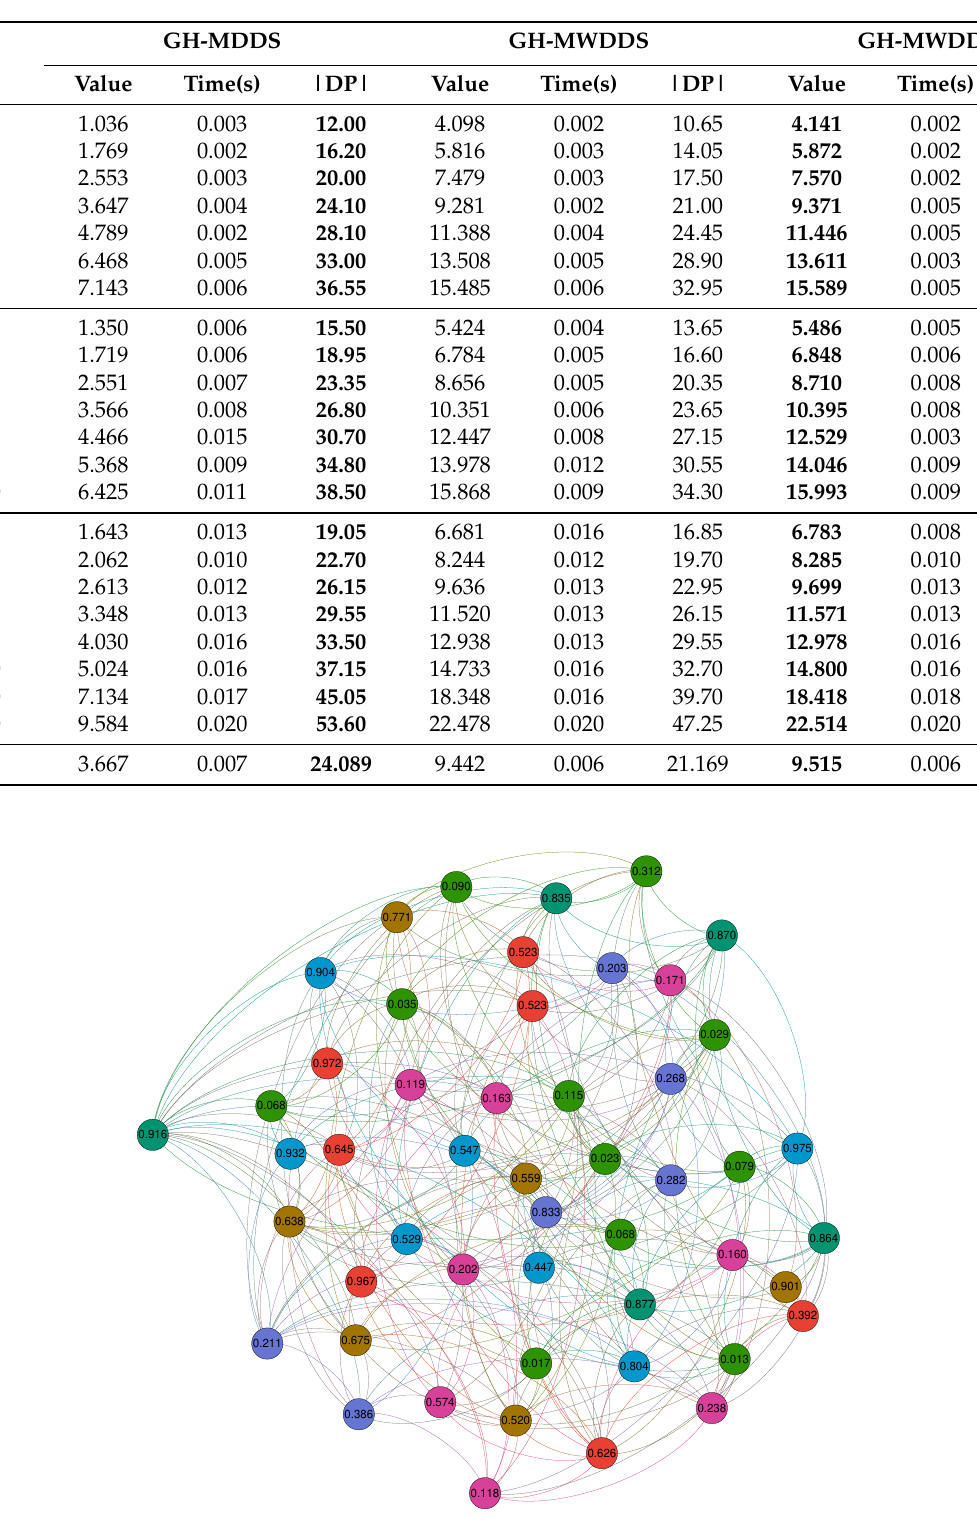
Figure 2. An optimal solution for network number 14 with 50 nodes and an average node degree of 15. The solution was produced by CPLEX. The color of the nodes indicates to which of six dominating sets they belong: Blue, dark blue, dark green, red, purple, and brown. The nodes colored in green do not belong to any dominating